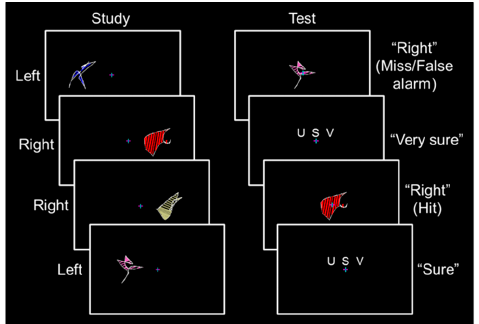
Figure 1. Stimulus protocol. Left , during the study phase, participants viewed abstract shapes to the left or right of fixation (labeled to the left). Right , during the test phase, old shapes were presented at fixation and participants classified each shape as previously on the “left” or “right” and made an “unsure”–“sure”–“very sure” confidence rating (possible responses and corresponding event types are shown to the right).